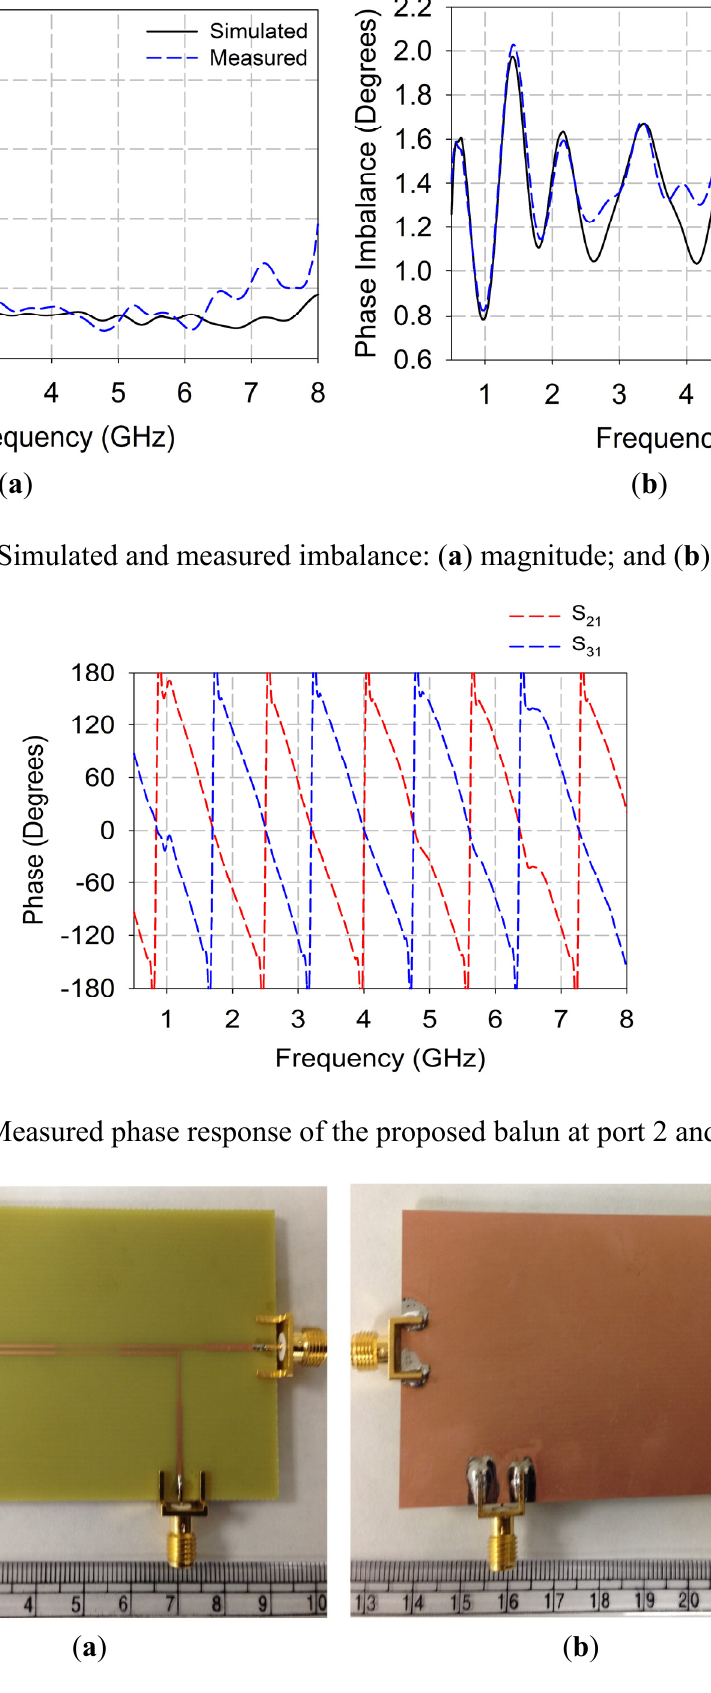
Figure 7. Photograph of the fabricated broadband balun: ( a ) top view; and ( b ) bottom